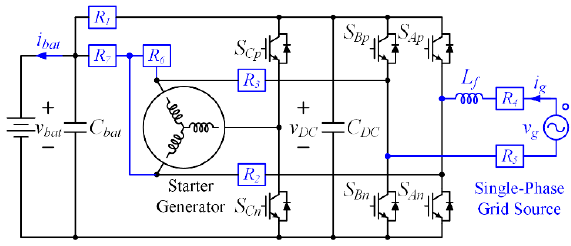
Figure 1. Circuit configuration of integrated OBC. Table 1. Comparison of main elements quantity and volume in HEV.